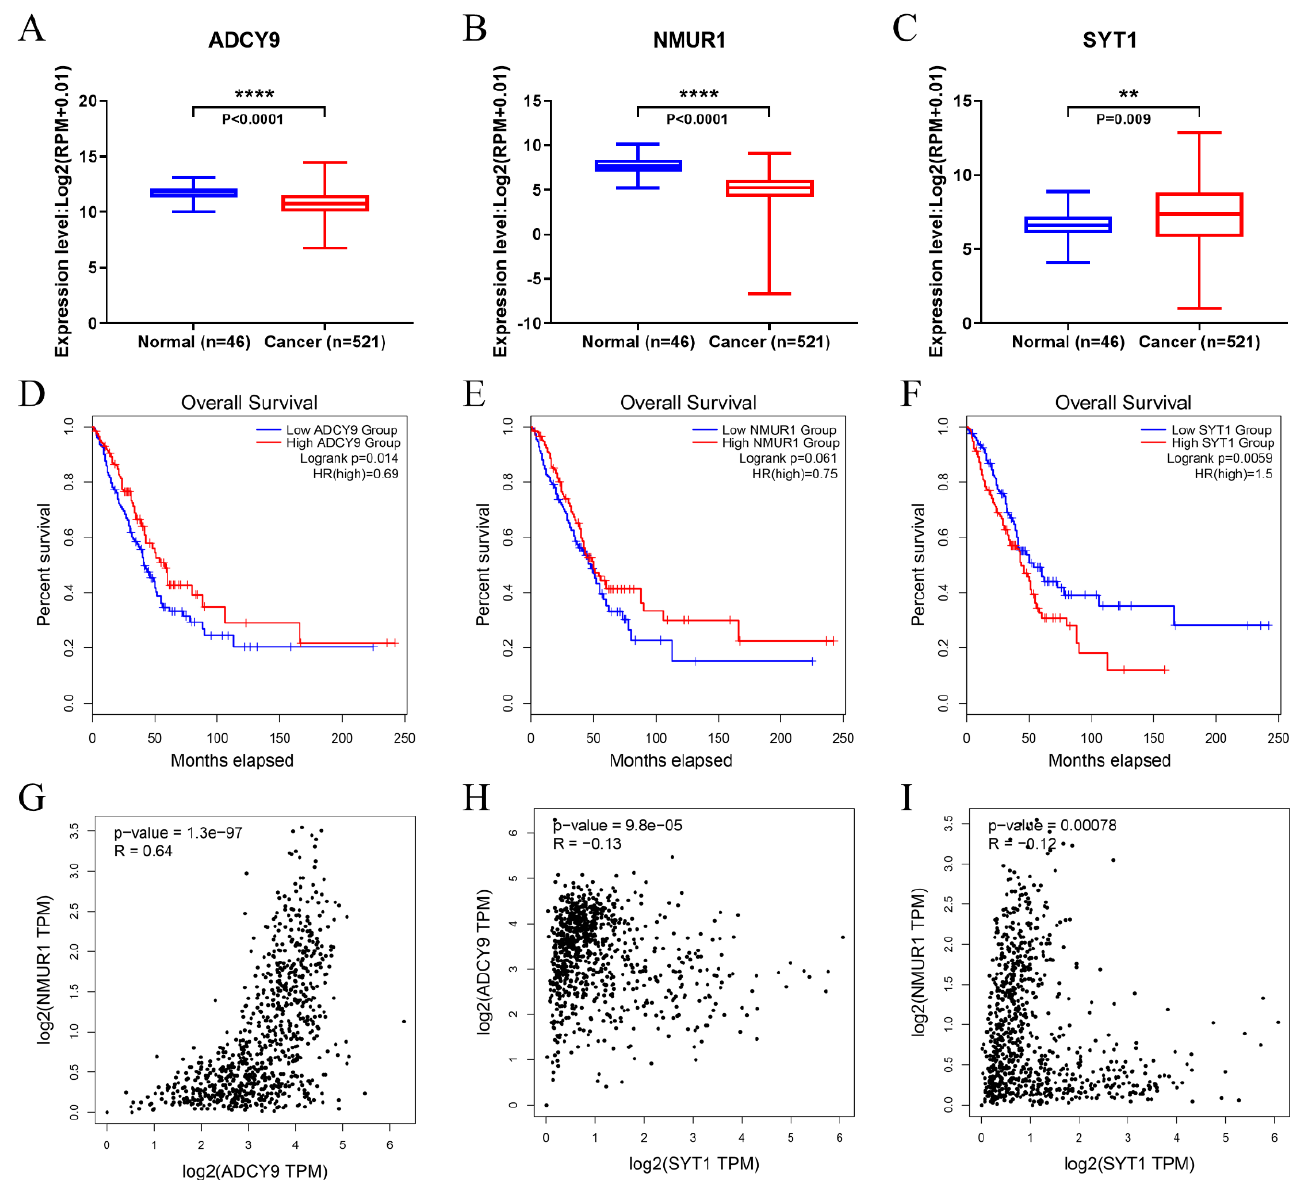
Figure 7. The expression level and OS time of 3 hub-genes, and correlation analysis for three differentially expressed hub-genes. ( A , D ) ADCY9 . ( B , E ) NMUR1 . ( C , F ) SYT1 . ( G ) The correlation of ADCY9 with NMUR1 in LUAD. ( H ) The correlation of ADCY9 with SYT1 in LUAD. ( I ) The correlation of NMUR1 with SYT1 in LUAD. “ ** ” means p < 0.01, “ **** ” means p < 0.0001.